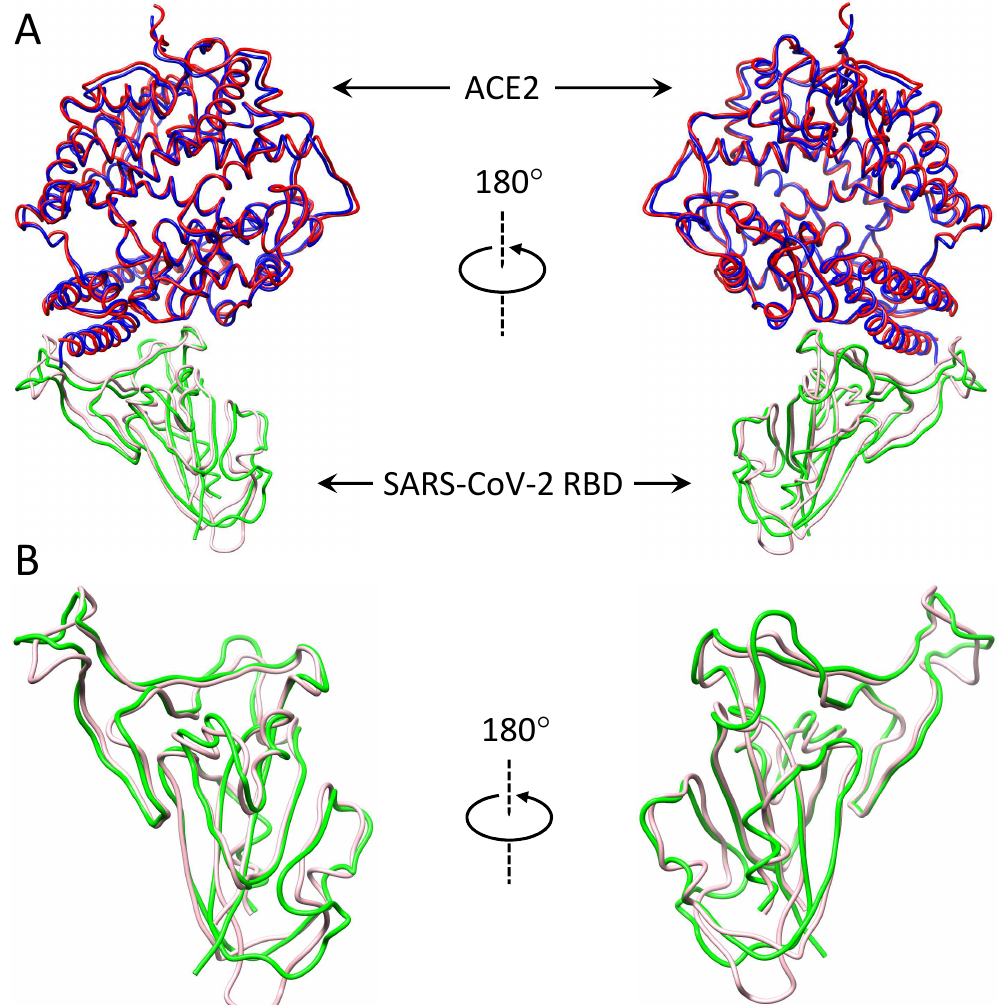
table that the binding free energy of the SARS-CoV-2 RBD-ACE2 interaction is − 50.43 kcal/mol, which is significantly lower than the binding free energy of the SARS-CoV RBD-ACE2 interaction ( − 36.75 kcal/mol). In other words, SARS-CoV-2 binds human ACE2 with a significantly higher affinity than SARS-CoV. Very recently, an experiment study also suggested that SARS-CoV-2 could bind human ACE2 with a higher affinity than SARS-CoV [30]. This may provide one of the possible reasons why SARS-CoV-2 is much more infectious than SARS-CoV, though other factors like human activities and pathogen persistence can also have a critical impact on the spread of SARS-CoV-2. Further examination of the binding free energy contributions reveals that the higher binding affinity of SARS-CoV-2 than SARS-CoV is mostly attributed to the solvation energy contribution ∆ G solv (674.97 vs. 696.56 kcal/mol), whereas SARS-CoV-2 has a higher binding free energy in vacuum ∆ G gas than SARS-CoV ( − 725.41 vs. − 733.31). In other words, SARS-CoV-2 tends to bind human ACE2 better than SARS-CoV in the water, while SARS-CoV would bind to human ACE2 better than SARS-CoV-2 in the gas. Further investigation will be needed to reveal the impact of such binding preferences on human infection.